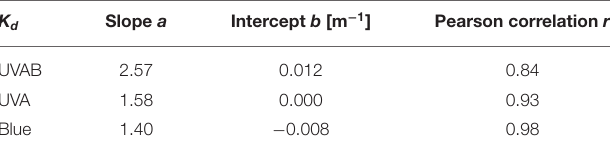
TABLE 1 | Linear least-square regression results for in-situ K d -UVAB, K d -UVA and K d -blue compared against in-situ K d (490) from 19 stations during PS113.